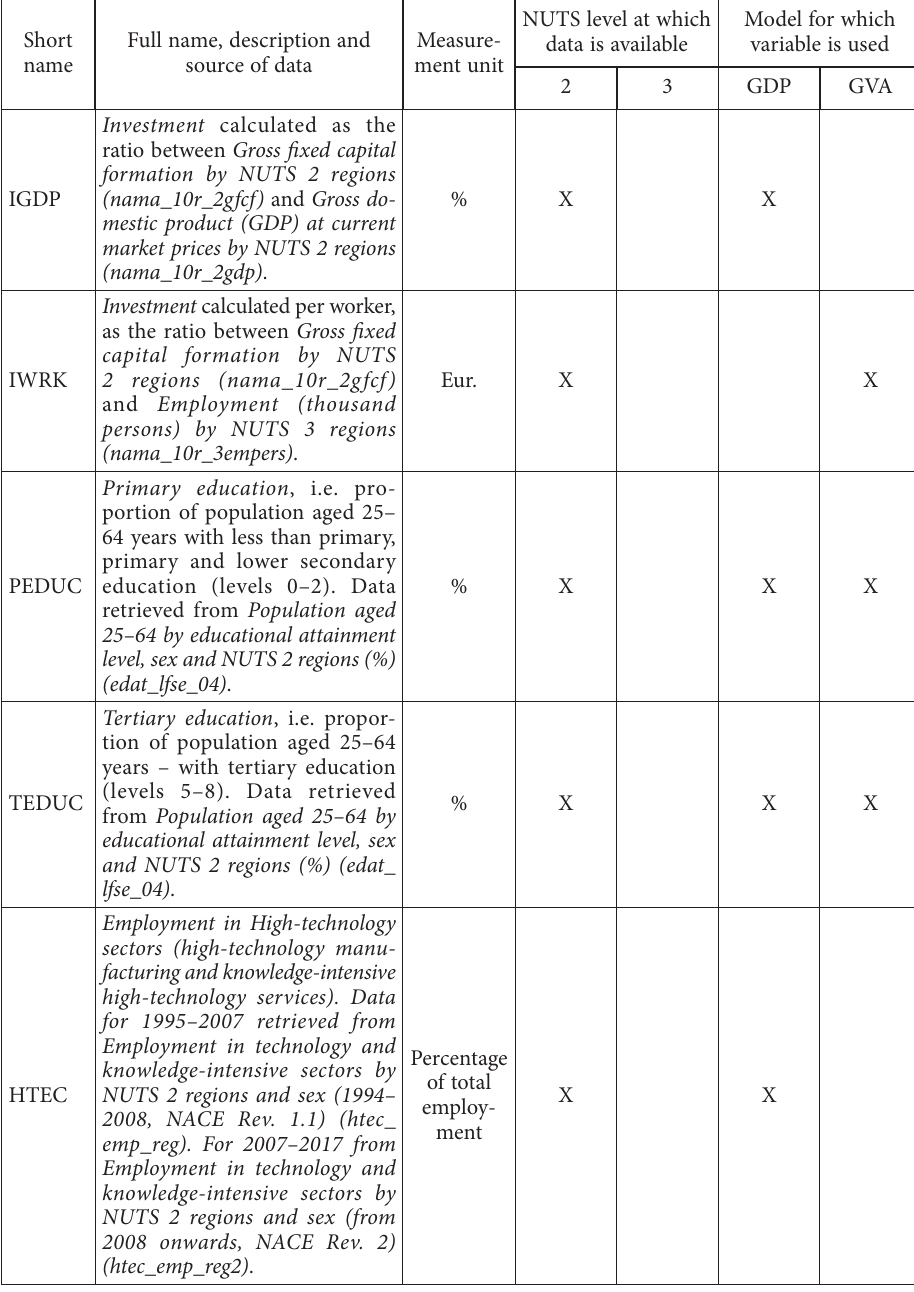
Table A2. Control variables 3 of the